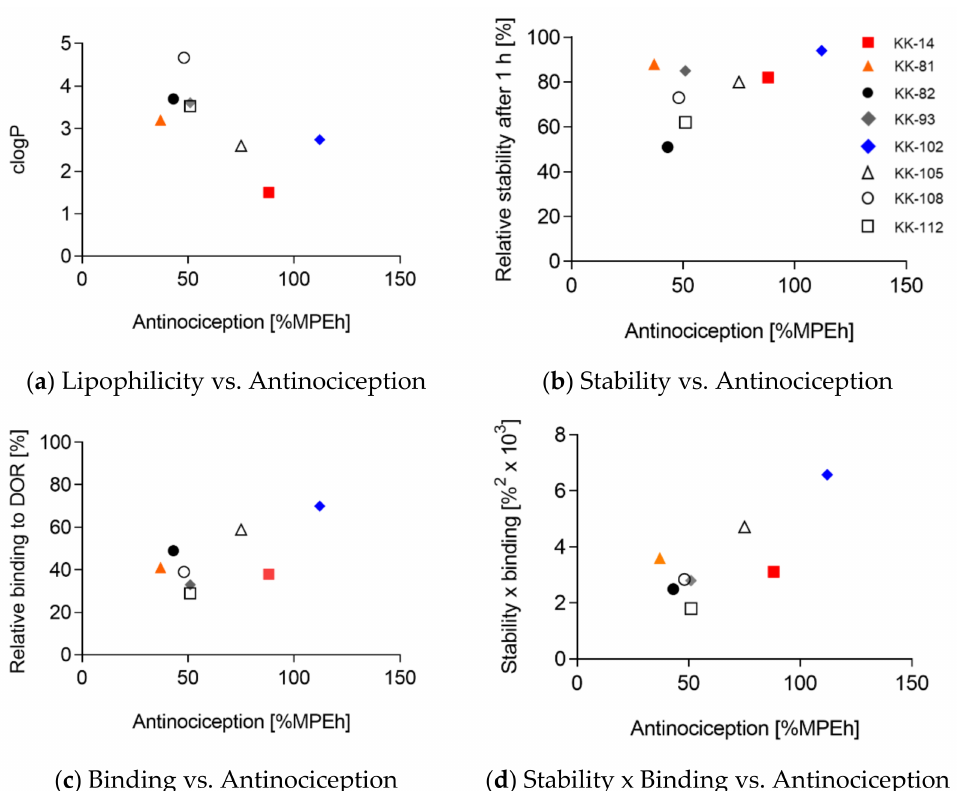
Figure 3. Pearson correlation between the AUC antinociception and ( a ) lipophilicity (clogP), ( b ) plasma stability, ( c ) DOR binding and ( d ) plasma stability × DOR binding of the Leu-ENK analogs.